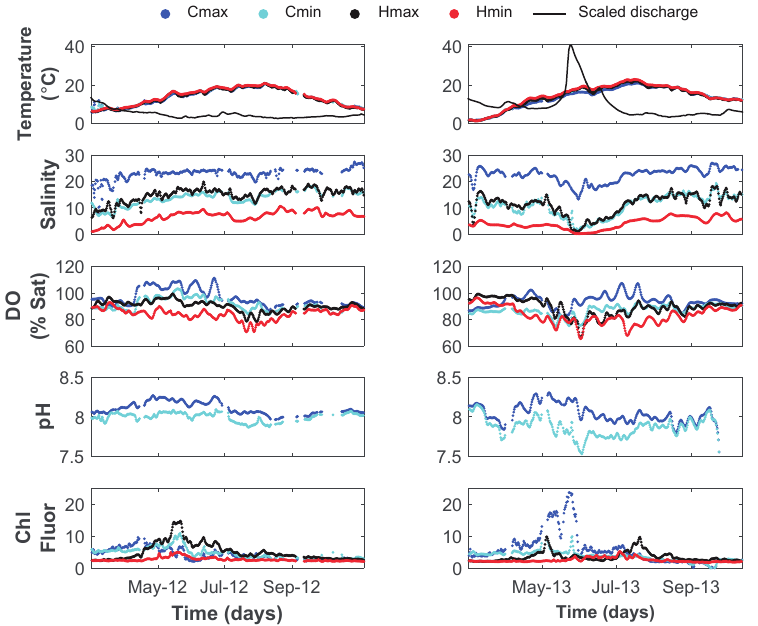
Figure 5. Temperature, salinity, DO (% saturation), pH and chlorophyll (fluorescence) measured at Cuxhaven and HPA pile in the Elbe estuary, for 2012 (left panels) and 2013 (right panels). The colors represent the data identified for each parameter, and at each station, at the times of salinity maxima (Cmax at Cuxhaven, blue; Hmax at HPA pile, black) and salinity minima (Cmin at Cuxhaven, cyan; Hmin at HPA pile, red). As a reference, the Elbe River discharge (originally measured in m 3 s − 1 ) at Neu Darchau station (Fig. 1) was scaled by dividing it by 100 and was included in the temperature plots.